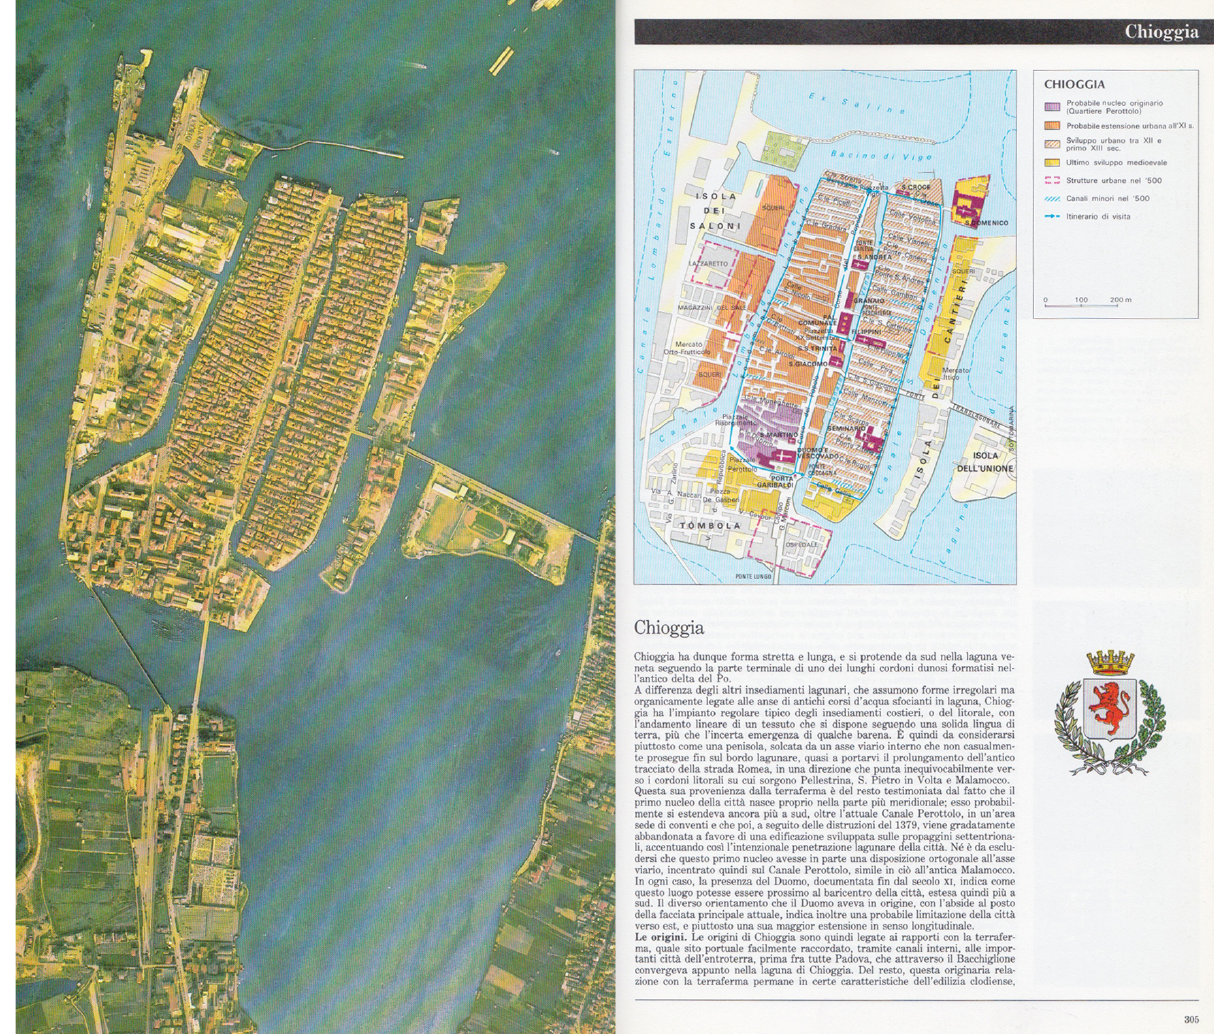
Fig. 10 An example of the pairing of aerial views and annotated maps from the first volume of the Guida ai centri minori: the town of Chioggia, Veneto. Courtesy of the